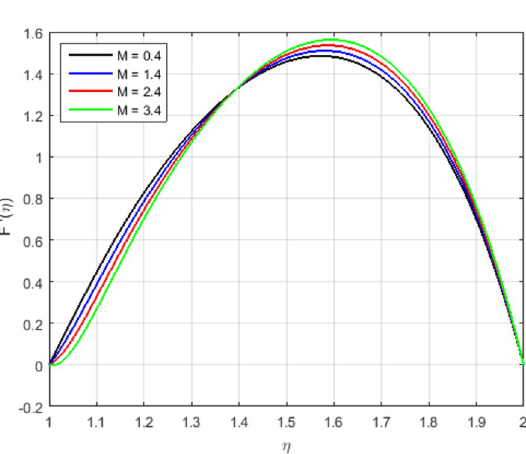
Figure 3. Influence of F ′ (η) for S > 0 , S < 0 and fixed values of Re m = 2.5, M = 0.5, Pr = 3.2, Hs = 0.2, C 1 = 0.4, Sc = 0.4, Sr = 0.5 .